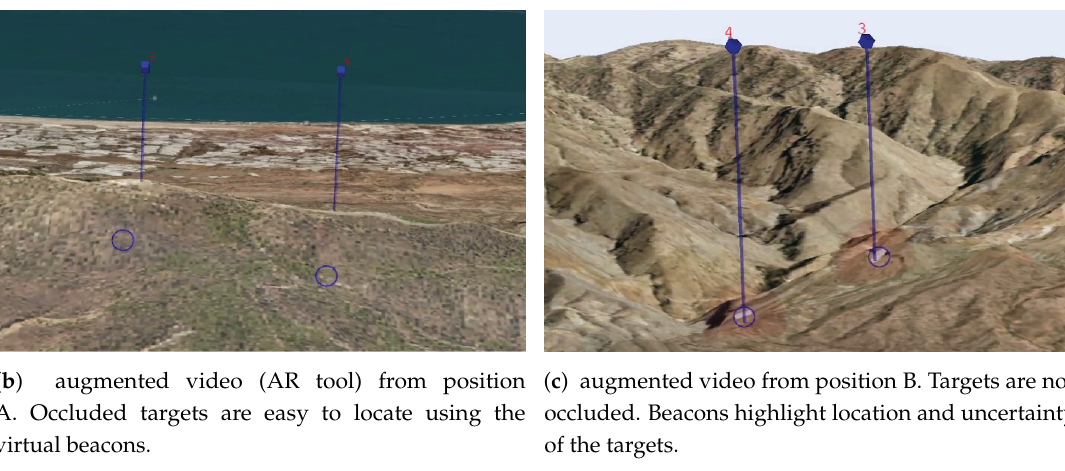
Figure 10. Target identification. Results of the AR tool, displayed on the screens of the GCS. A blue circle is surrounding the targets to mark the true